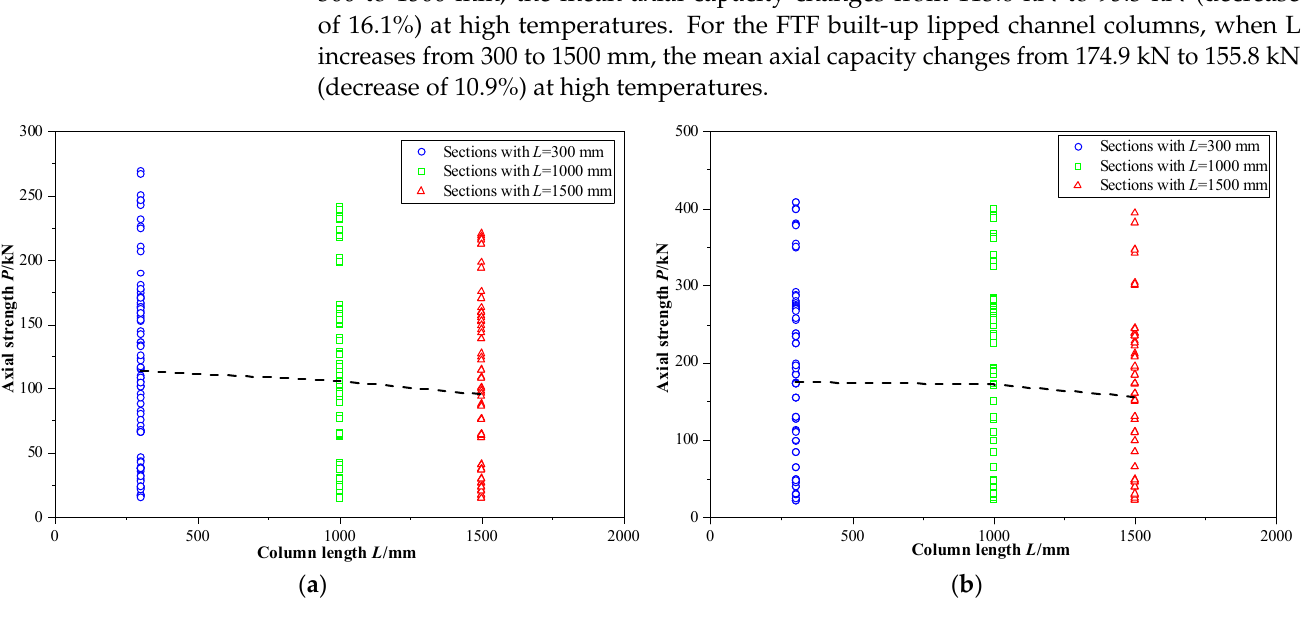
Figure 7. Influence of column length ( L ): ( a ) CFS-FTF built-up unlipped channel columns with different lengths; and ( b ) CFS-FTF built-up lipped channel columns with different lengths.